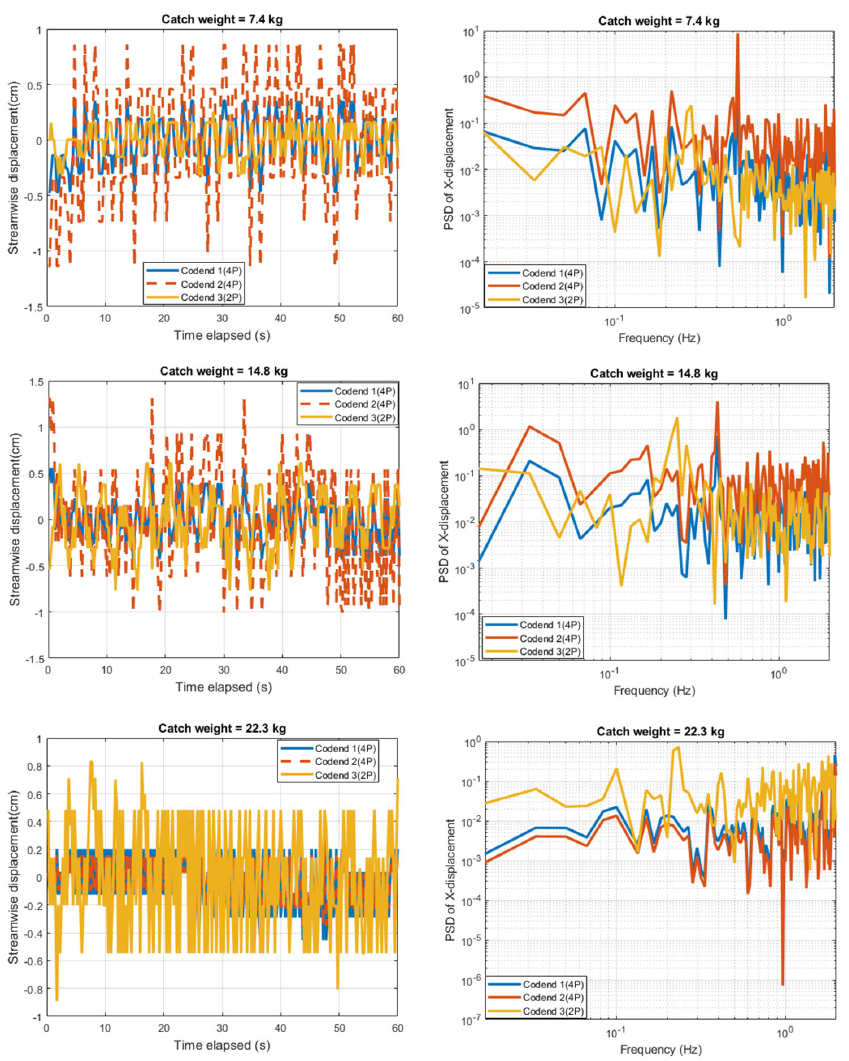
Figure 10. Fluctuations of the x—structure motion of the three codends ( left ) associated to the power spectral density (PSD) representation (in a log–log scale) ( right ) at different catch weights.